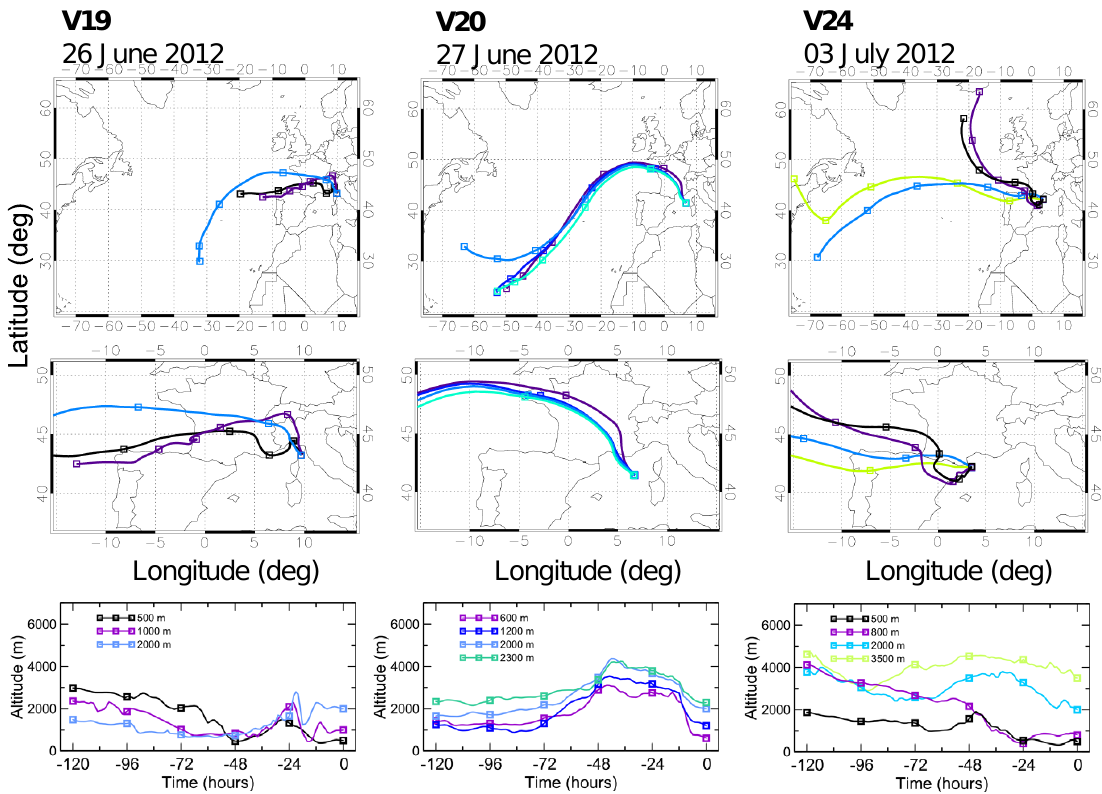
Figure 9. Five-day backward air mass trajectories for the V19, V20, and V24 flights calculated with the FLEXTRA model. The upper panel shows the trajectories over an extended latitude–longitude region, while the central panel focuses on the western Mediterranean area. The altitude of the air masses and its temporal evolution along the 5-day trajectories is reported in the lower panel of each